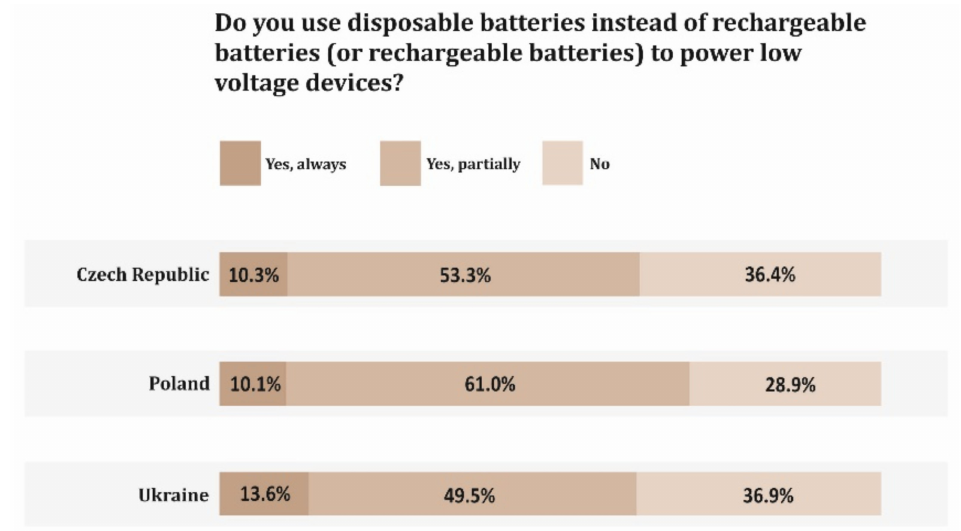
Figure 8. Distribution of answers regarding the use of rechargeable batteries. Source: own study.